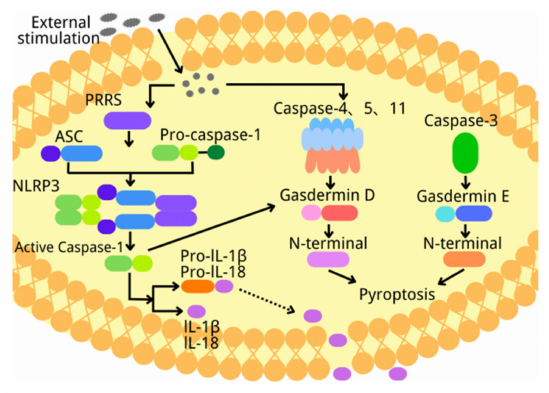
Figure 1. The process of three types of